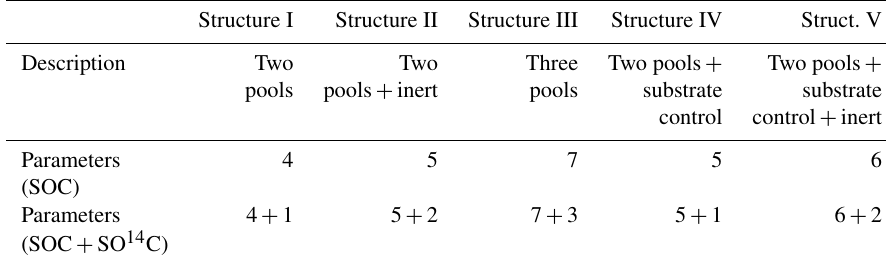
Table 2. Summary of the model structures tested in this study (considered here in their basic forms for total C only and for the two isotopes